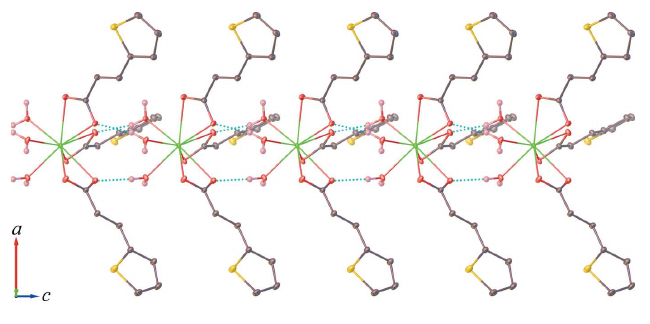
Figure 3 The one-dimensional hydrogen-bonded chain in the title compound 1 running parallel to the c axis.